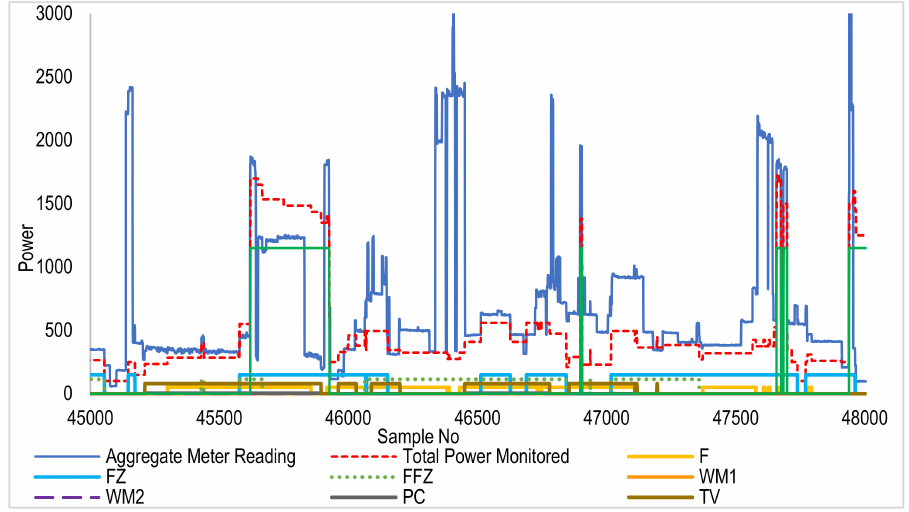
Figure 8. Aggregate and clustered REFIT data (samples: 45,000 to 48,000 window). As indicated in the legend, each device’s disaggregated profile is shown in a different color. The red plot is the sum of disaggregated devices’ energy. It is seen that the trend of sum (red) follows the aggregate (blue) at each instant showing the effectiveness of the